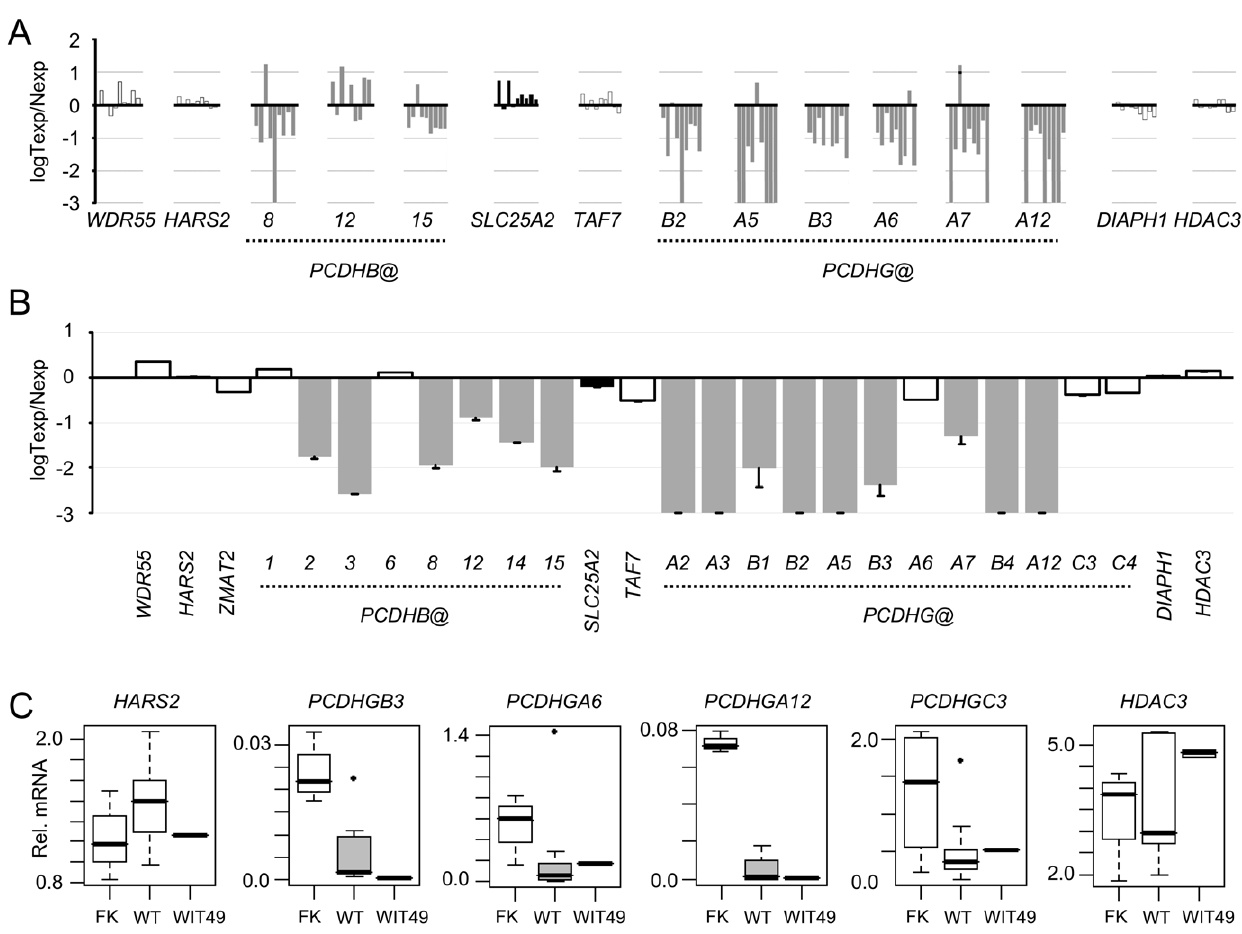
Figure 2. Silencing of PCDH expression in Wilms’ tumour. (A) Expression levels of genes across the locus in 9 tumours (Texp), relative to the mean of 4 normal fetal kidney samples (N exp). Grey bars are used for genes showing tumour-specific hypermethylation, white bars for unmethylated genes and black bars for the constitutively methylated SLC25A2 gene. (B) Expression levels of 5q31 transcripts correspond with DNA methylation status in WiT49 cells. Expression of unmethylated genes (white bars), constitutively methylated genes (black bar) and hypermethylated PCDH s (grey bars) are shown. (C) Suppression of methylated and unmethylated PCDH s within the chromosome 5q31 LRES. Gene expression levels relative to the house-keeping gene TBP are shown. Horizontal black line, median value; box, interquartile range; whiskers, data range excluding outliers; black dots, outliers (defined as those data points greater than range multiplied by inter-quartile range beyond the box). Grey boxes give samples shown to be hypermethylated, open boxes represent unmethylated